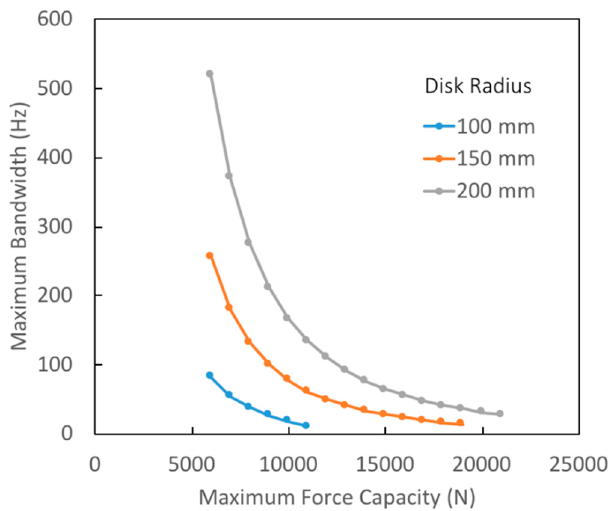
Figure 5. Pareto-optimal curves showing maximum achievable actuator bandwidth as a function of maximum force for various values of the maximum allowable disk outer radius.